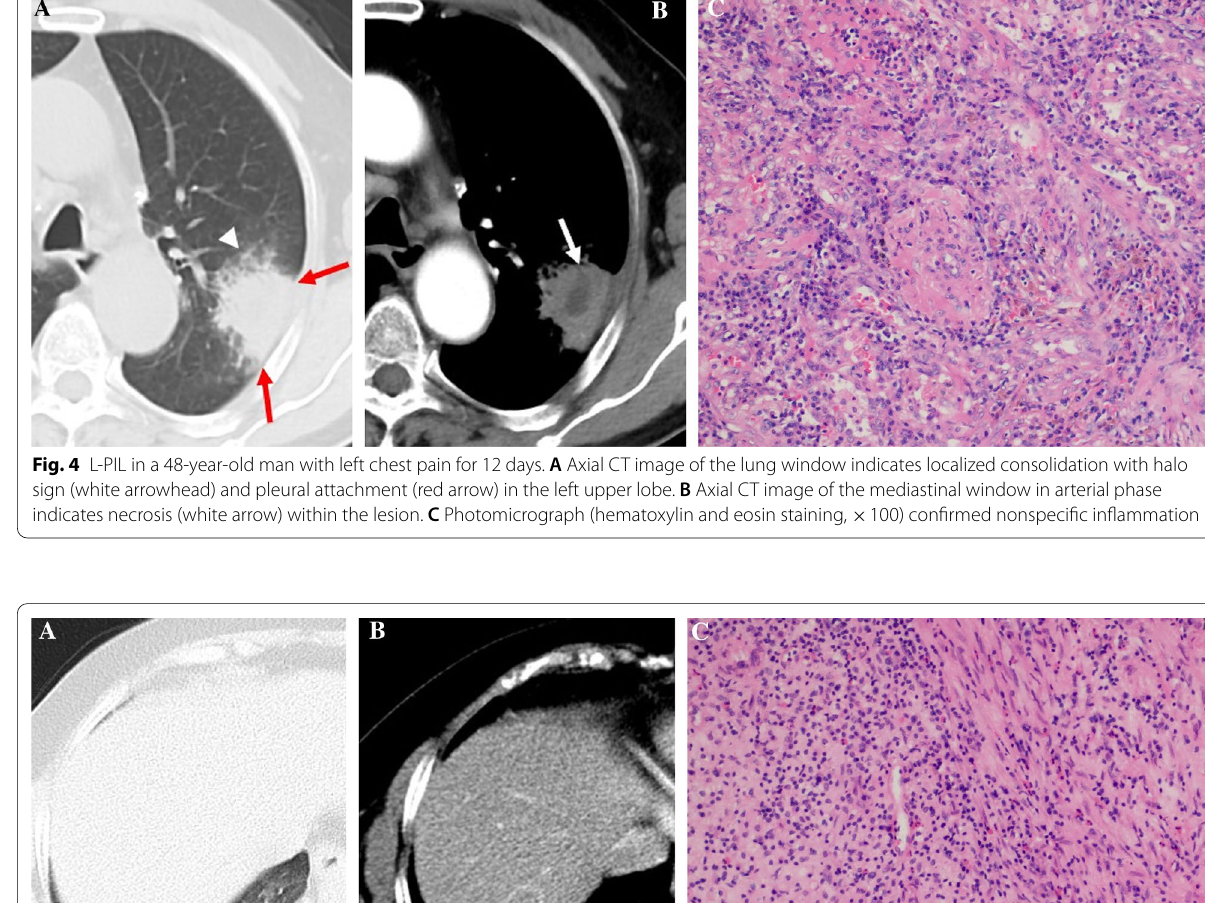
Fig. 5 L‑PIL in a 66‑year‑old woman with cough and hemoptysis for two weeks. A Axial CT image of the lung window indicates localized consolidation with halo sign (white arrowhead), adjacent interlobular septa thickening (yellow arrow), and pleural attachment (red arrow) in the right lower lobe. B Axial CT image of the mediastinal window in arterial phase indicates necrosis (white arrow) within the lesion. C Photomicrograph (hematoxylin and eosin staining, 100) confirmed inflammatory ×